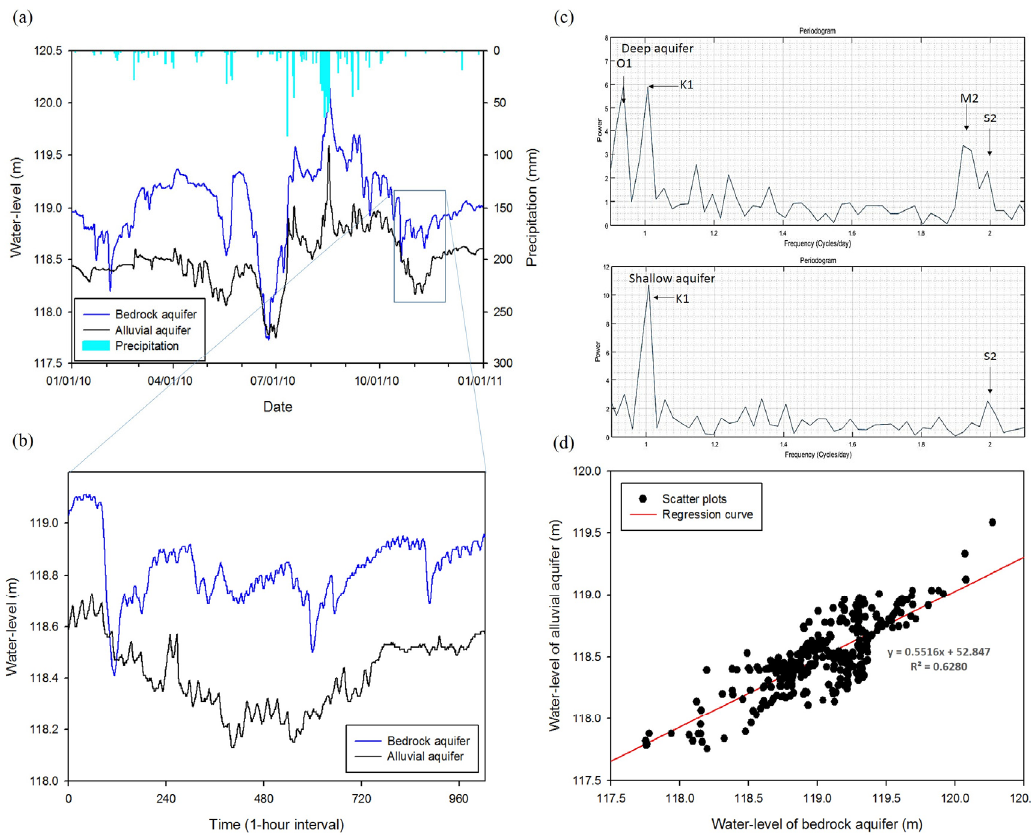
Figure 7. Results of the correlation analysis and harmonic analysis of the paired water-level data from shallow and deep monitoring wells in 2010 for Type II with low similarity between water-level fluctuation pairs, low correlation coefficients and different aquifer characteristics: ( a ) groundwater hydrograph; ( b ) one-hour interval data for spectral analysis; ( c ) signal components; and ( d ) correlated data.